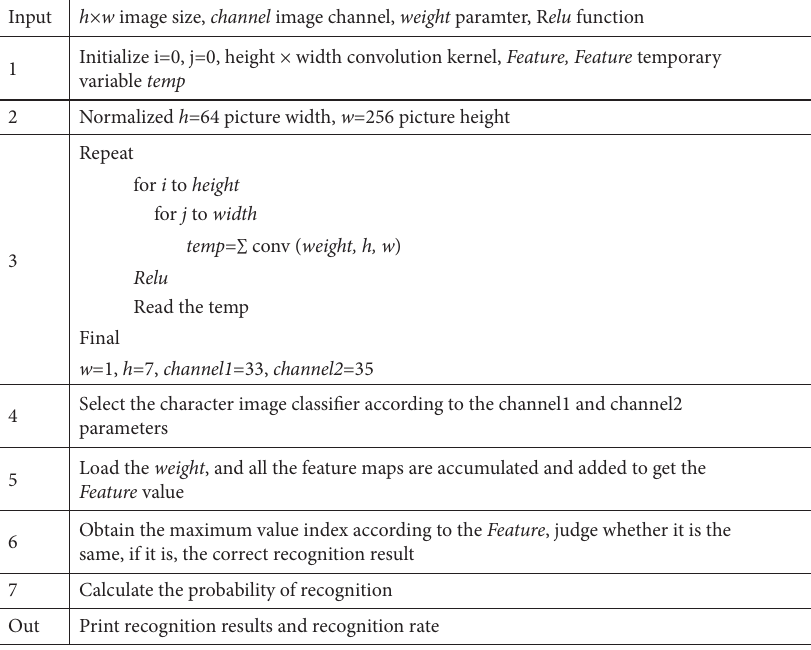
Figure 4: Pseudocode of fast-LPRNet